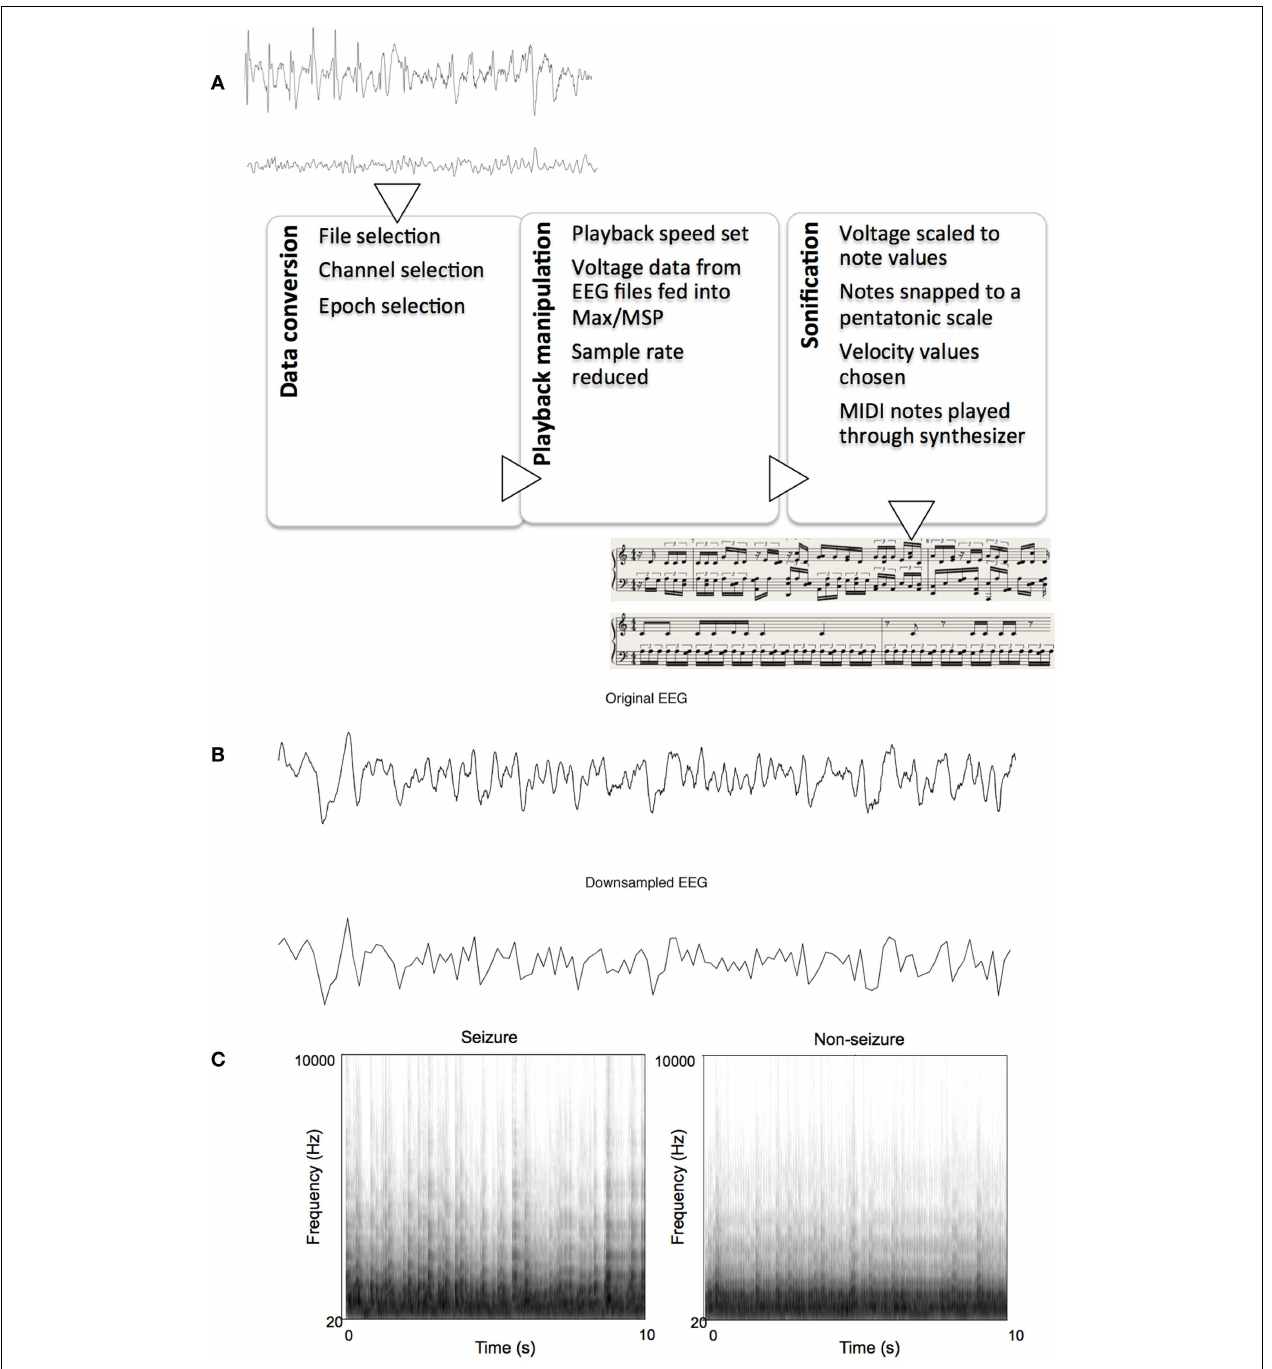
FIGURE 1 |The sonification process . (A) Flowchart of sonification process, showing seizure and non-seizure EEGs, and their respective sonified scores, (B) Example of a 10-s seizure EEG epoch before and after down-sampling, (C) Example spectrograms of sonified EEGs: one seizure and one